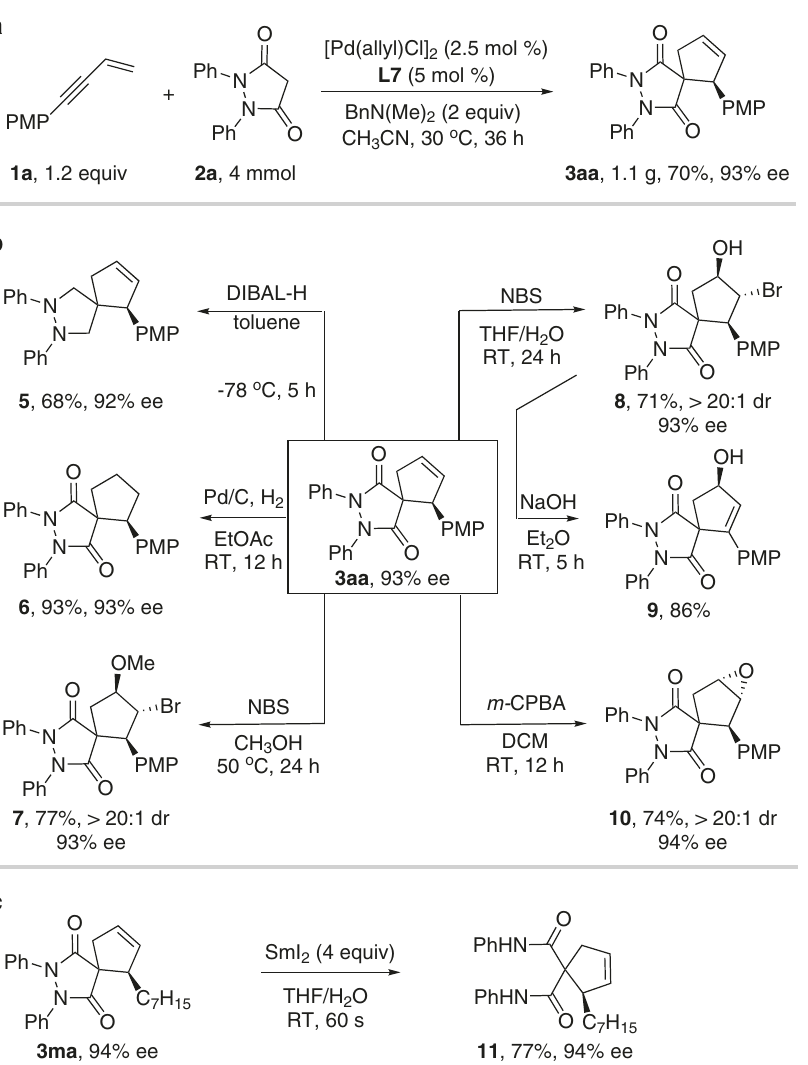
Fig. 5 Synthetic applications. a Gram-scale experiment. b Synthetic transformations of product 3aa (hydrogenation, alkoxybromination, hydroxybromination, and epoxidation of C = C double bond, reduction of amide group). c Synthetic transformation of product 3ma (reductive cleavage of the N – N bond). DIBAL-H diisobutylaluminum hydride, NBS N -Bromosuccinimide, m -CPBA m -Chloroperbenzoic acid, THF tetrahydrofuran, DCM